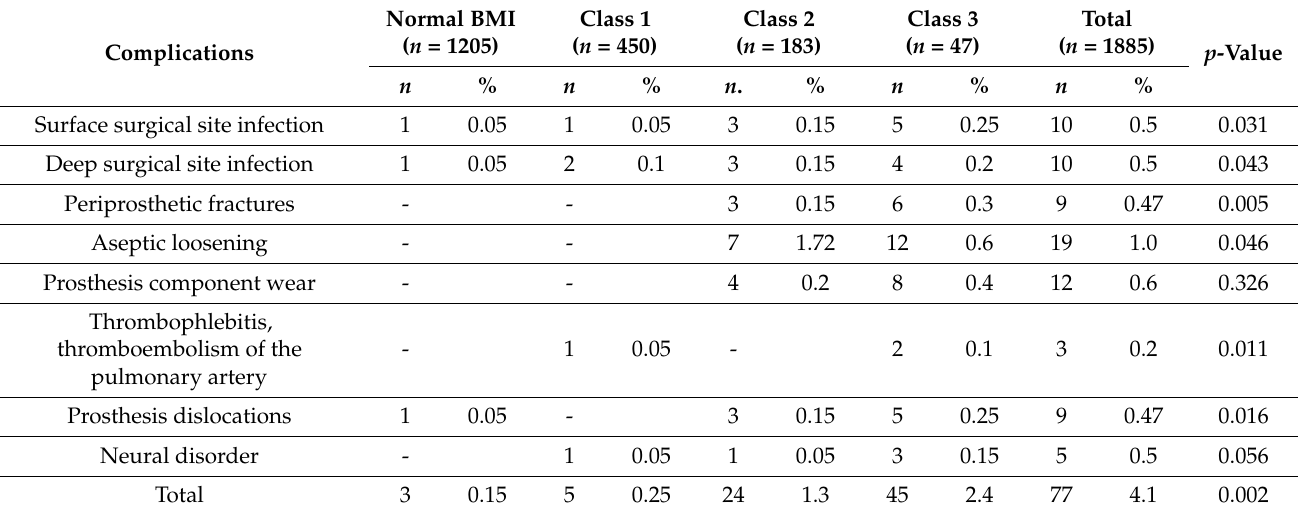
Table 3. Stage 1 of the